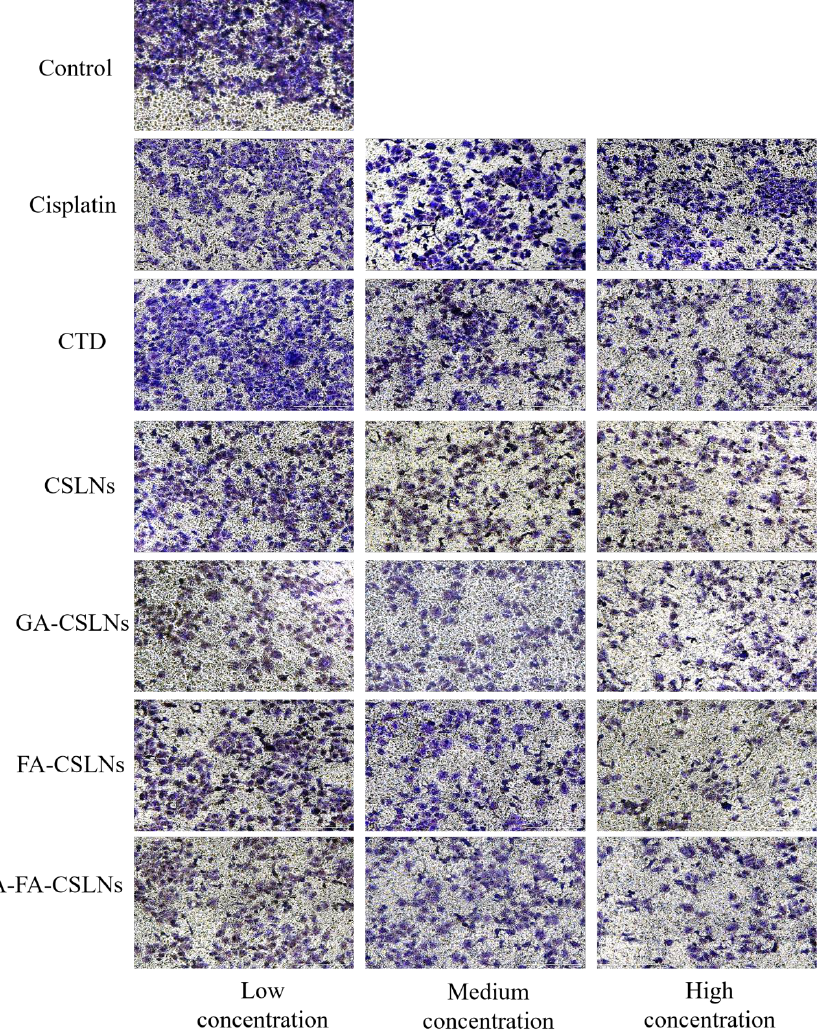
Figure 7. Cell migration assays at 24 h after treatment with various formulations observed at 10 × 10 magnification.